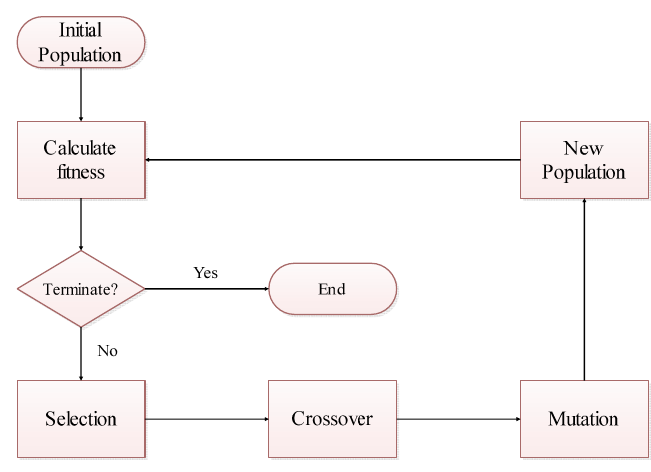
Figure 2. Flowchart of the genetic algorithm.